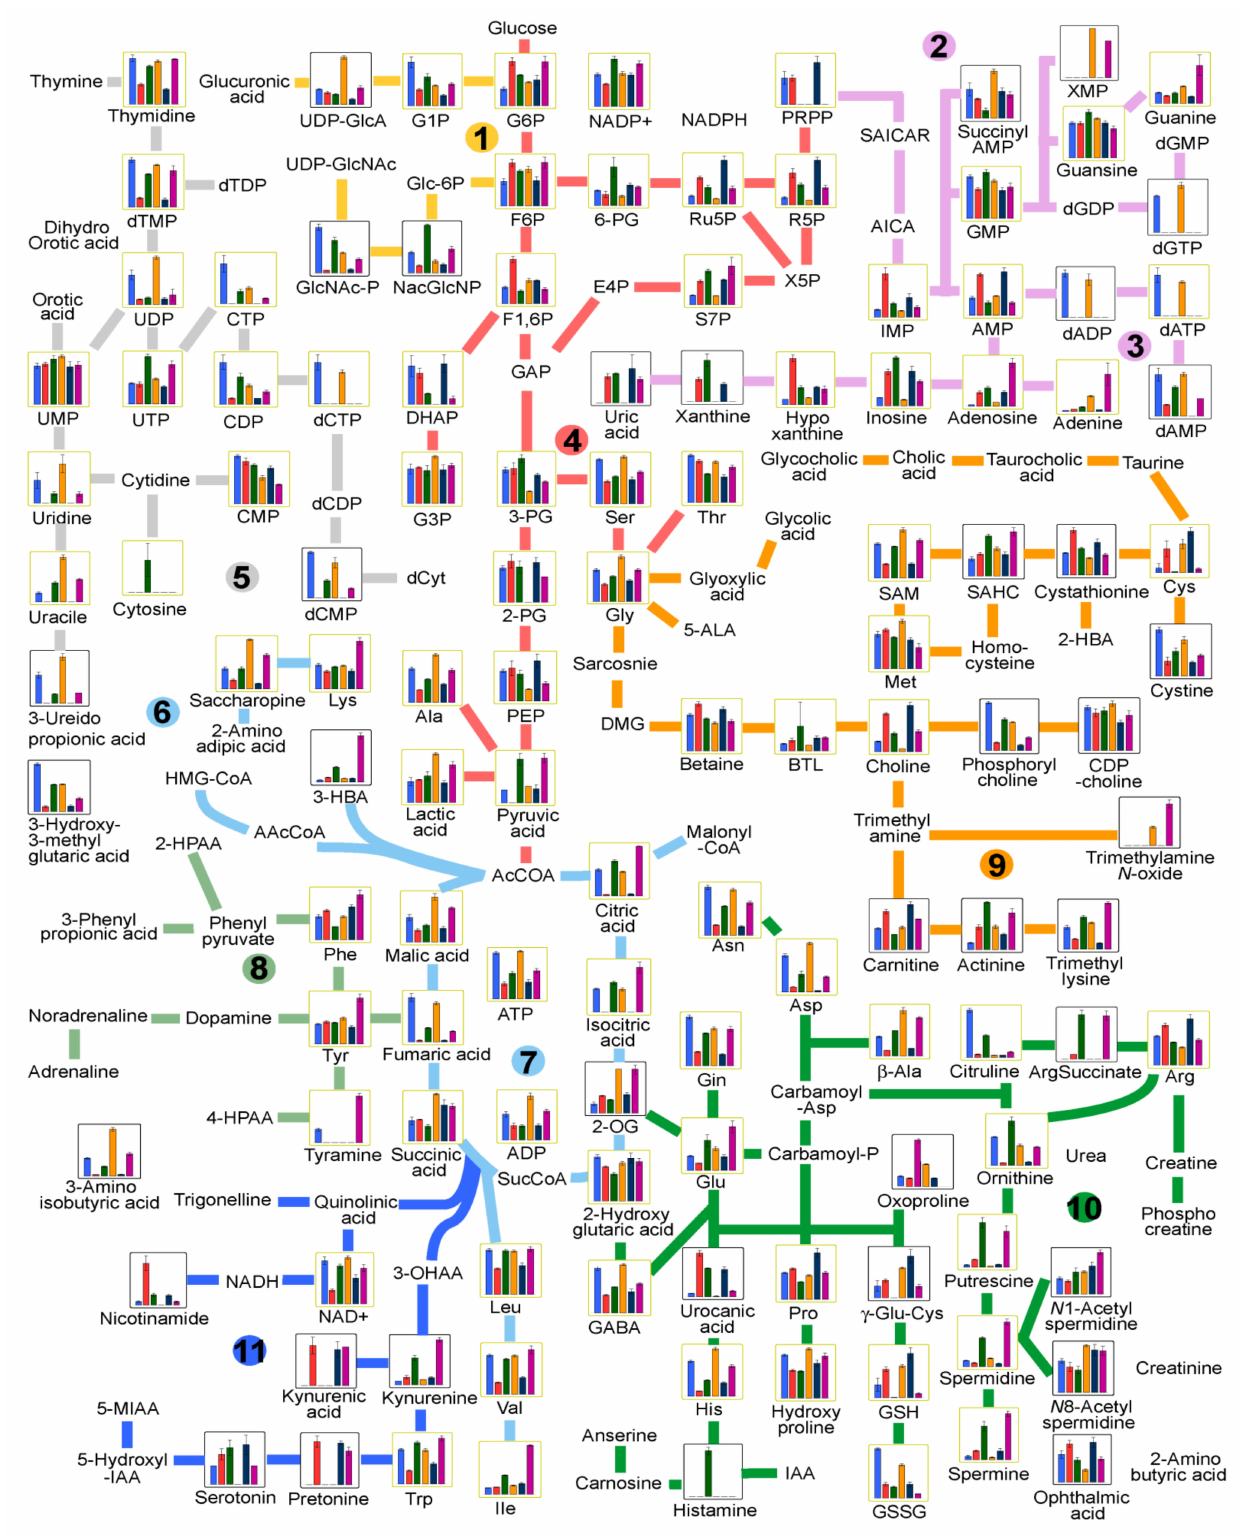
Figure 1. Integrated superimposed metabolic pathway map. Carbohydrate metabolism ( 1 ); purine metabolism ( 2 , 3 ); glycolysis and gluconeogenesis metabolism ( 4 ); pyrimidine metabolism ( 5 ); TCA cycle to store energy ( 6 ); TCA cycle for energy conversion: β -oxidation and BCAA metabolism ( 7 ); aromatic amino acid metabolism-phenylalanine and tyrosine ( 8 ); choline metabolism and methionine salvage ( 9 ); glutamate metabolism and urea cycle ( 10 ); and aromatic amino acid metabolism- tryptophan ( 11 ). The bars/lines represent peak areas of metabolites in H. schachtii egg (blue), H. schachtii juvenile 2 (red), H. schachtii female (green), H. trifolii egg (orange), H. trifolii juvenile 2 (mazarine), H. trifolii female (purple), respectively. Boxes with no bars indicate metabolites not detected. Refer Table S2 for the